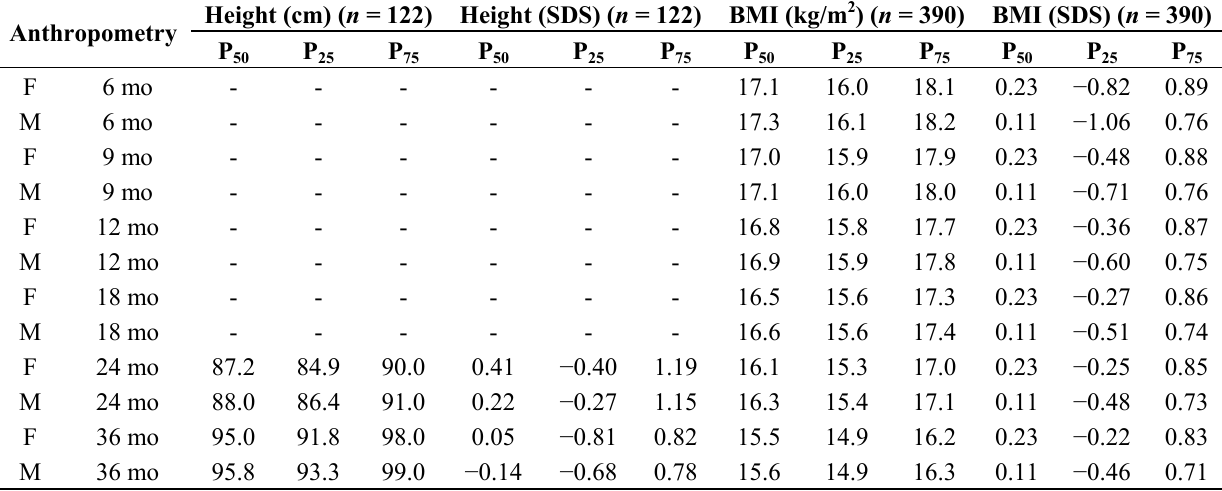
Table 4. Percentiles of height and body mass index in the pooled sample of NI636 children.